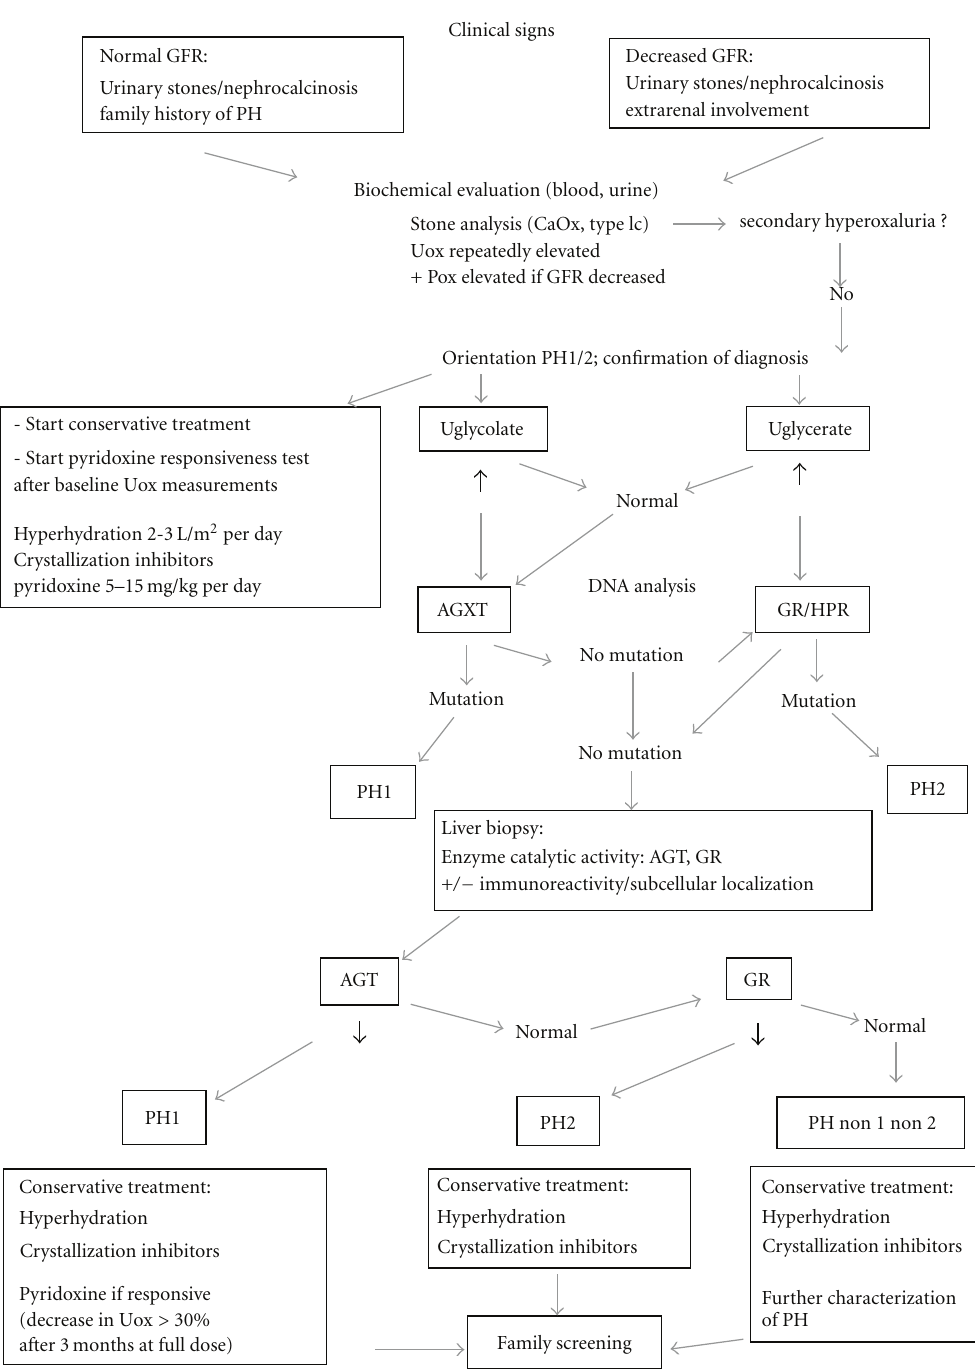
Figure 5: Proposed algorithm for the diagnosis and conservative treatment of primary hyperoxalurias. Abbreviations: PH: primary hyperoxaluria; GFR: glomerular filtration rate; Uox: urinary oxalate; Pox: plasma oxalate; CaOx: calcium oxalate; AGT: alanine:glyoxylate amino transferase; AGXT: AGT gene; GR/HPR: glyoxylate reductase/hydroxypyruvate